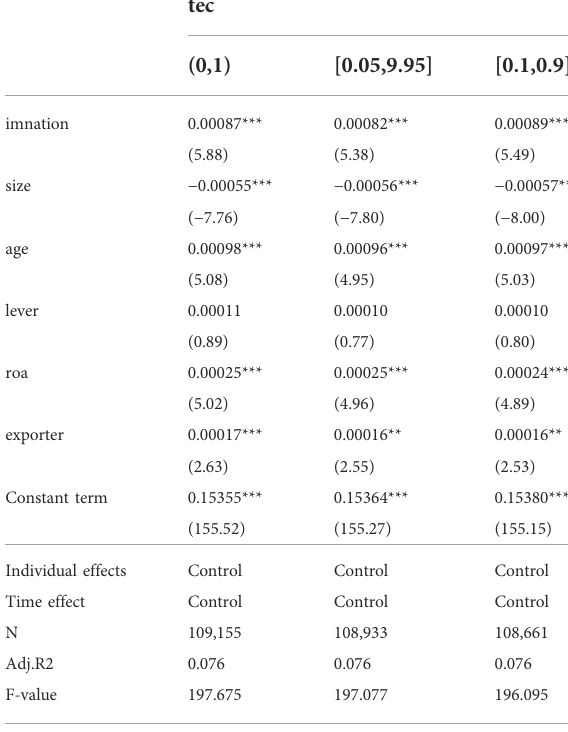
TABLE 5 Use of new product output value instead of technical progress rate.